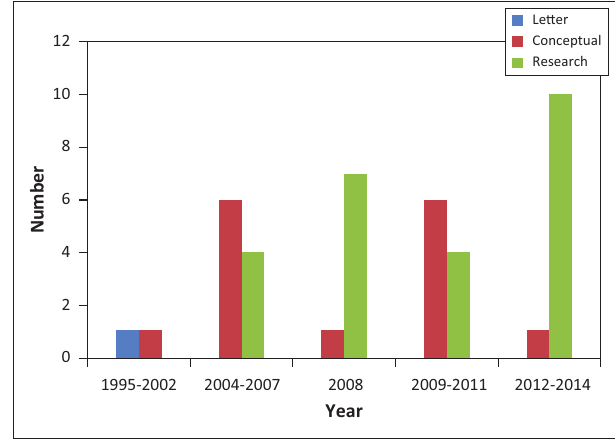
TABLE 2: Area of focus for articles included in narrative review. Primary focus